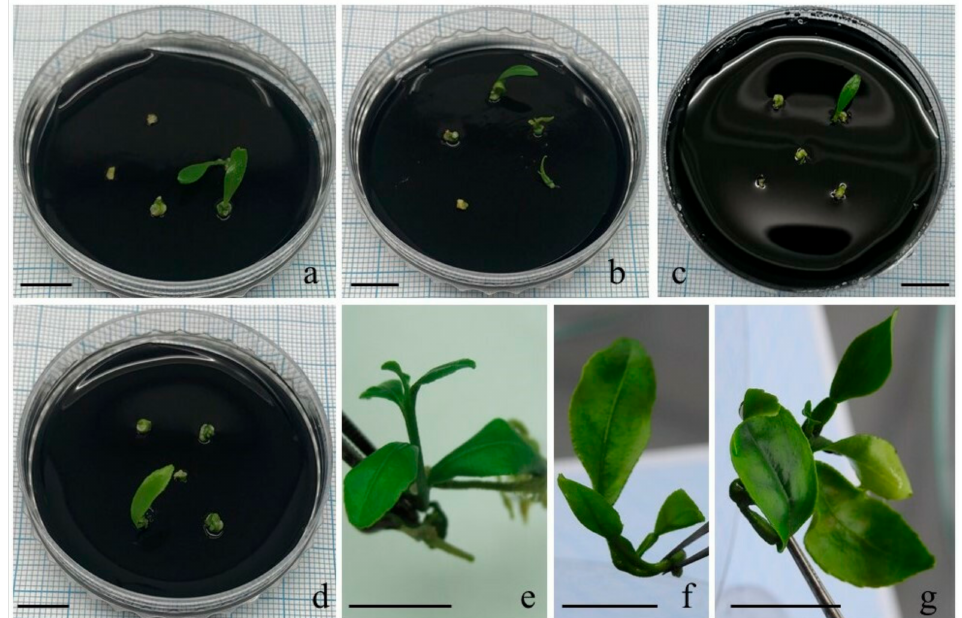
Figure 4. The shoot tip regrowth of Citrus spp. after optimized cryopreservation. After three days of cold-hardening application, shoot tip explants cut in 0.3–0.7 mm size were taken to the sucrose preculture stage on solid WPM nutrient medium containing 0.25 M sucrose. Then, they were kept in droplets containing 3 µ L PVS2 for 45 min, and they were incubated on solid WPM nutrient medium containing 1 mg.L − 1 BAP and 10 mg.L − 1 charcoal for 24 h. Then, they were transferred to WPM solid nutrient medium supplemented with 1 mg.L − 1 BAP, 1 mg.L − 1 H 3 BO 3 , and 10 mg.L − 1 charcoal ( a ) cv. Bodrum Mandarin; ( b ) cv. Klin Mandarin; ( c ) white grapefruit and ( d ) red grapefruit after four weeks incubation; ( e ) cv. Bodrum Mandarin; ( f ) cv. Klin Mandarin; ( g ) red grapefruit after eight weeks incubation, bars 1